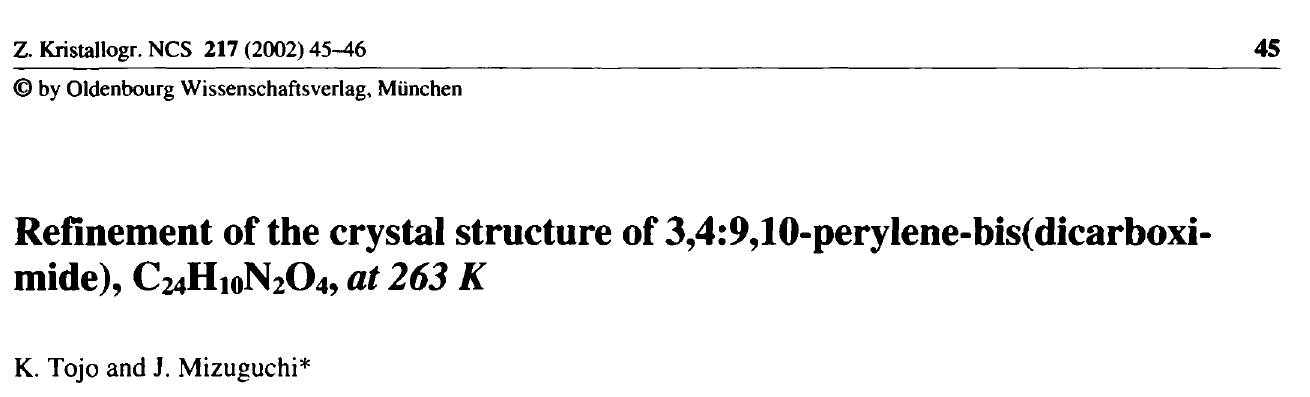
Table 1. Data collection and handling.